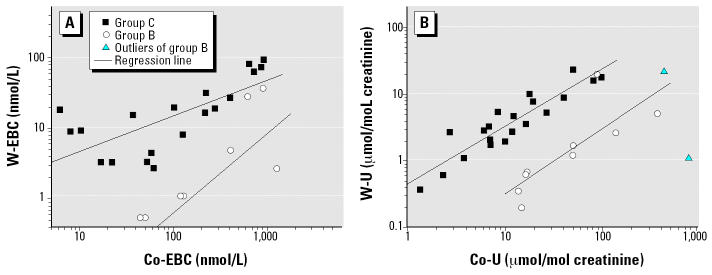
Correlation (A) between Co-EBC and W-EBC levels and (B) between Co-U and W-U levels. In (A), group B log(W-EBC) = 2.44 + log(Co-EBC1.12)and Group C log(W-EBC) = 0.15 + log(Co-EBC0.51). In (B), group B log(W-U) = 1.47 + log(Co-EBC0.97) and Group C log(W-U = 0.35 + log(Co-EBC0.86).